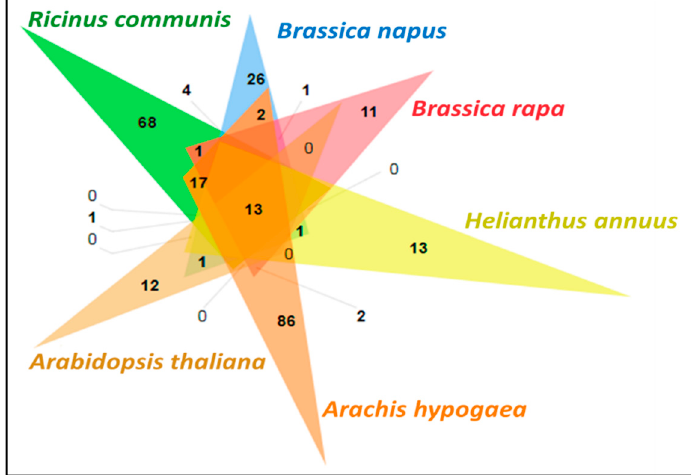
Figure 7. Comprehensive comparative protein analysis of RJC1 with Ricinus communis , Brassica napus , Brassica rapa , Helianthus annuus , Arachis hypogaea , and Arabidopsis thaliana